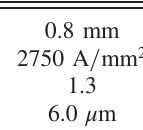
TABLE VII. SSC inner NbTi